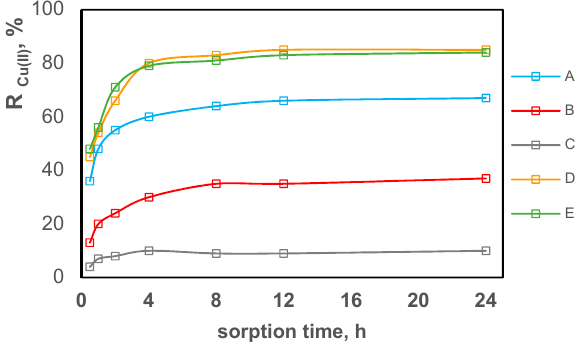
Figure 8. The reduction in copper ion concentration expressed as a percentage of sorption on PVC-based composites promoted with acac depending on the contact duration.